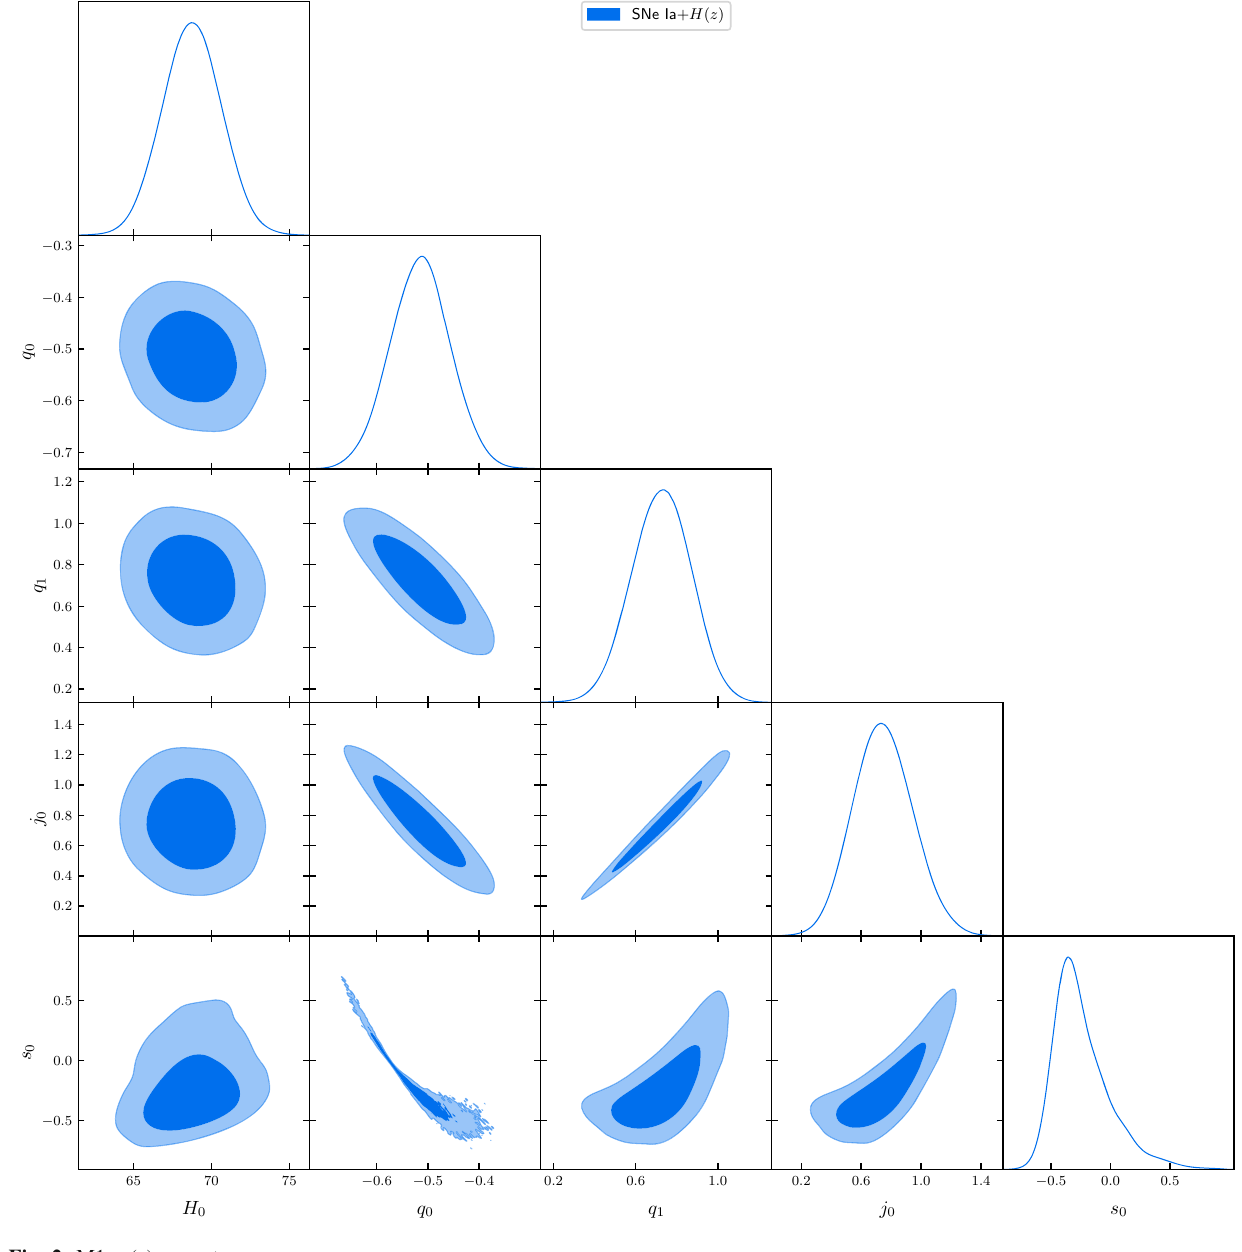
Fig. 2 M1: q ( z ) = q 0 + q 1